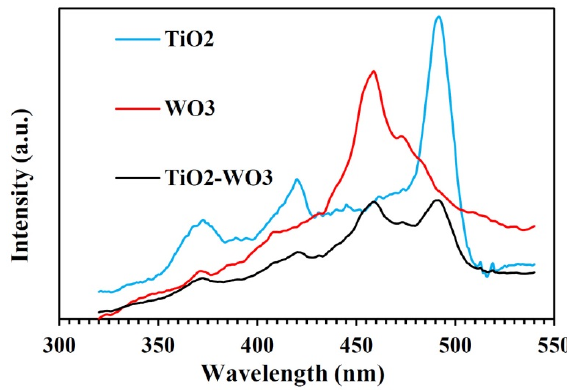
Fig. 4. PL spectra of the prepared